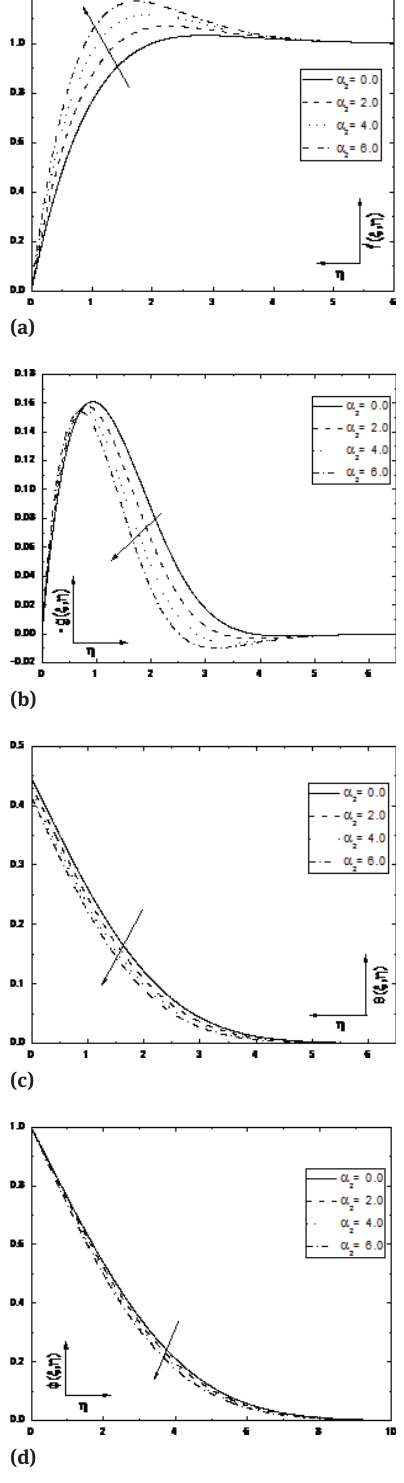
Fig. 3: Effect of nonlinear concentration parameters on the (a) ve- locity, (b) microrotation, (c) temperature and (d) concentration for Δ = 1.0, Fs = 0.5, α 1 = 5, Ω = π /6, Bi = 0.5, ξ = 0.5